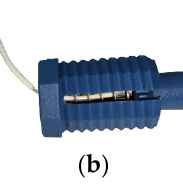
Figure 3. Dry electrode. ( a ) Dry comb electrode. ( b ) Wired holder.